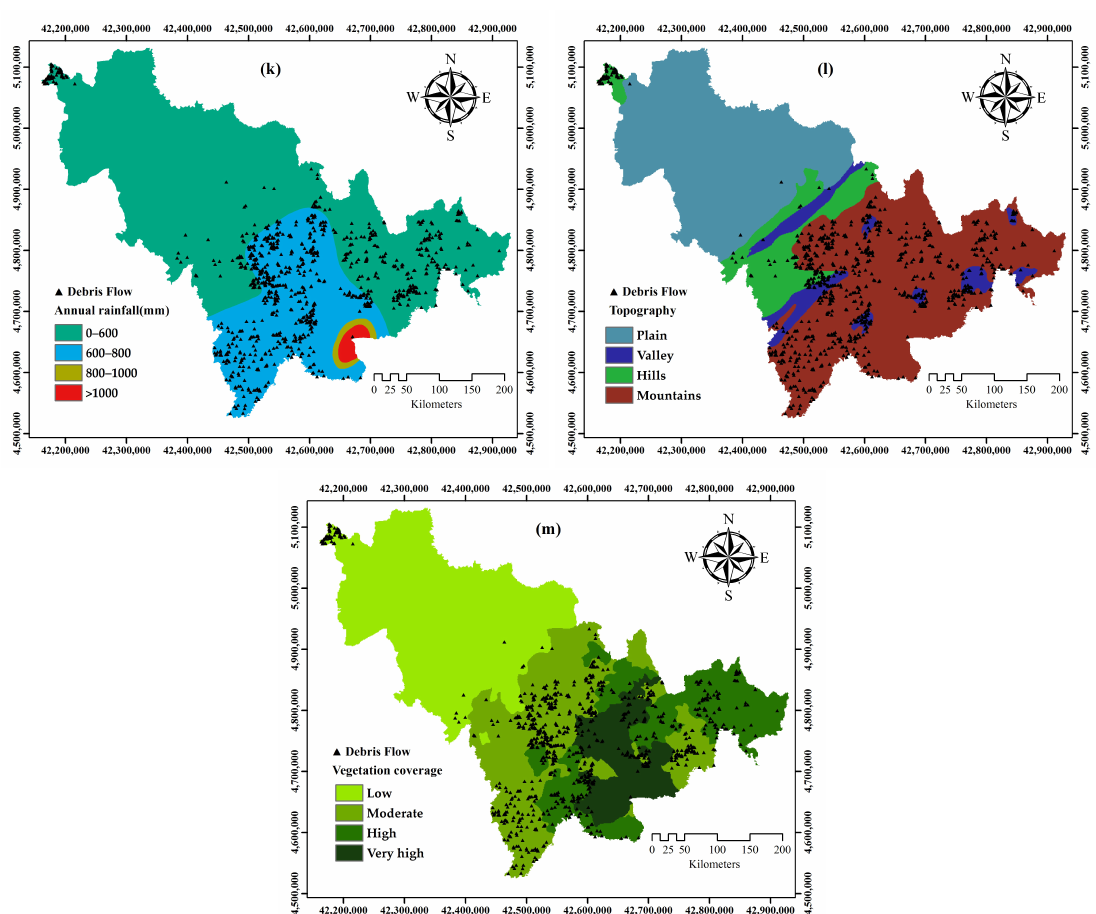
Figure 5. Debris flow influencing factors used in this study: ( a ) elevation, ( b ) slope, ( c ) aspect, ( d ) plan curvature, ( e ) profile curvature, ( f ) topographic wetness index (TWI), ( g ) distance to roads, ( h ) distance to rivers, ( i ) lithology, ( j ) population density, ( k ) annual rainfall, ( l ) topography, ( m ) vegetation